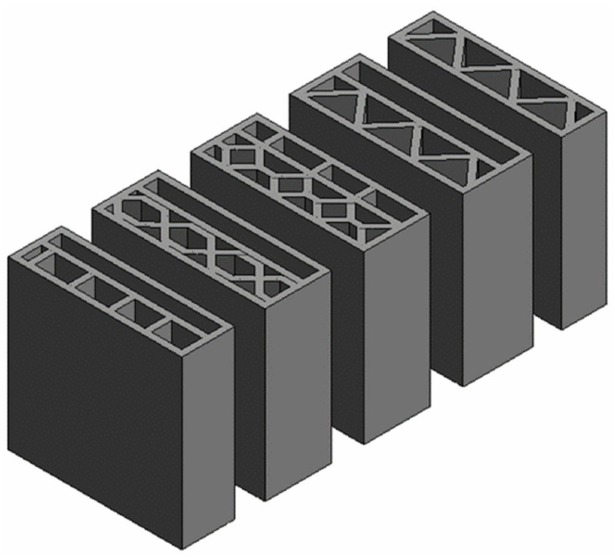
Figure 1. Types of enclosing